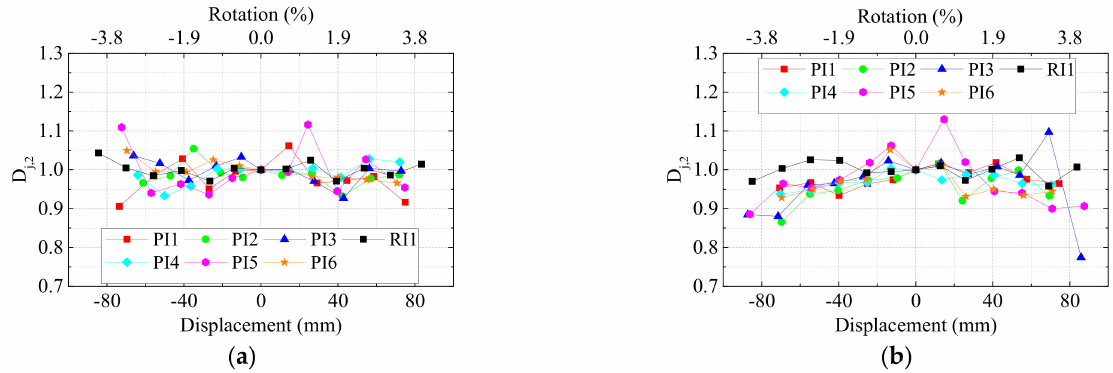
Figure 10. Strength degradation coefficient D j ,2 . ( a ) Left beams and ( b ) right beams.